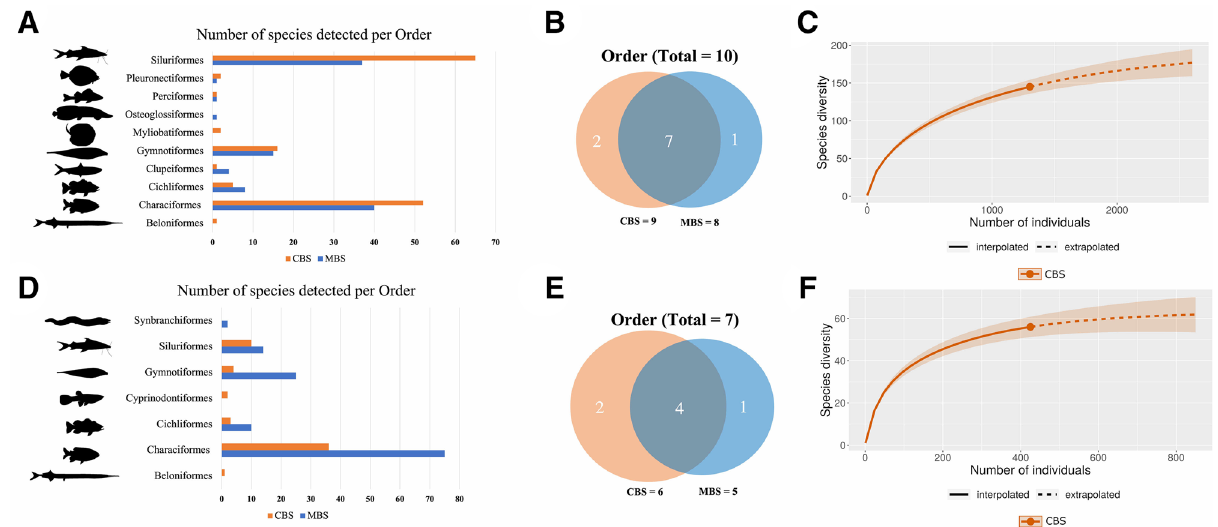
Figure 4. Comparison between Capture-Based Sampling (CBS) in blue and Molecular-Based Sampling (MBS) in red in two sampled localities. Javari River: ( A ) Histogram comparing the number of species per order detected by CBS and MBS; ( B ) Venn diagram of the number of orders detected by CBS and MBS; ( C ) Rarefaction species accumulation curve for CBS with 95% confidence interval and extrapolation for twice the number of individuals sampled. Terra firme stream: ( D ) Histogram comparing the number of species per order detected by CBS and MBS; ( E ) Venn diagram of the number of orders detected by CBS and MBS; ( F ) Rarefaction species accumulation curve for CBS with 95% confidence interval and extrapolation for twice the number of individuals